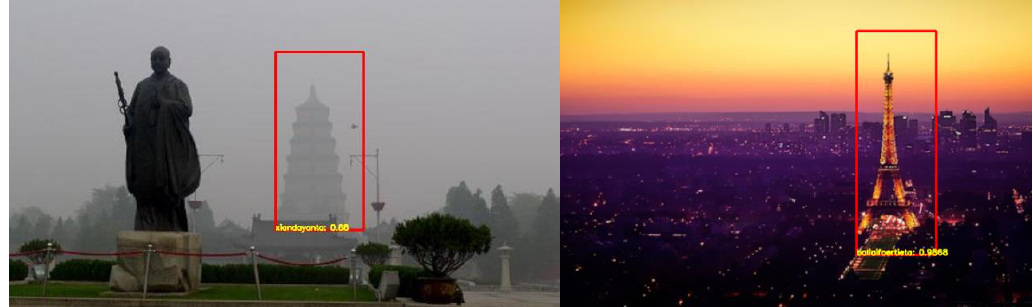
Figure 10. Test images in complex environments.